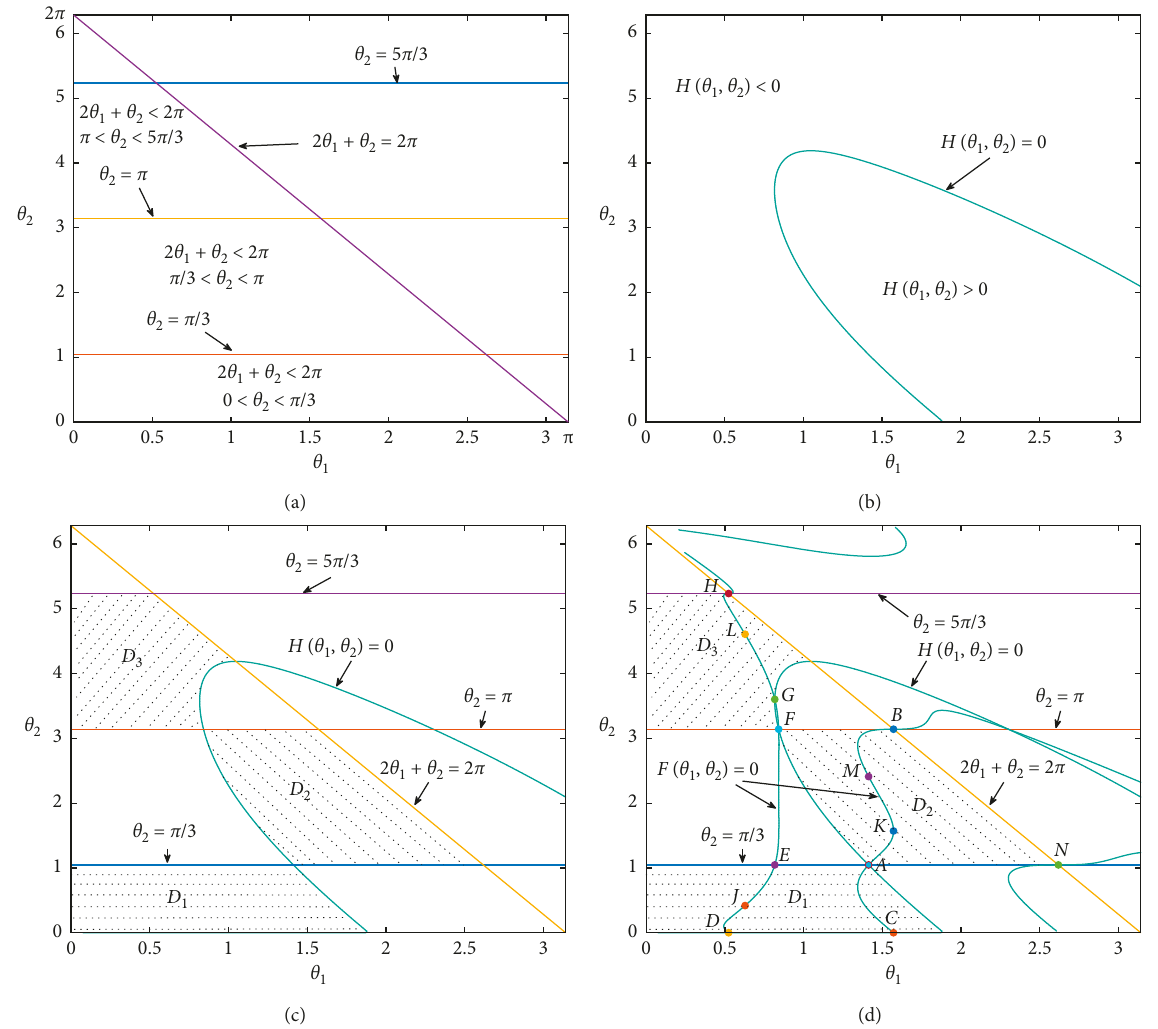
Figure 5: Graphs for Conjecture 1. (a) The straight lines θ � 2 π − 2 θ − θ ) > 0, for θ > 0, f ( θ ∈ ( 0 , π /3 ) ∪ ( π , 5 π /3 ) . (b) The sign of f ( θ θ 4 1 2 2 2 regions D , D , and D defined in (38). (d) The curve F ( θ 1 2 3 end points. Points A , K , and J correspond to the central configurations in Theorems 1 and 3 and Proposition 1, respectively. Points L and M correspond to the same central configurations in Theorems 1 and 3,